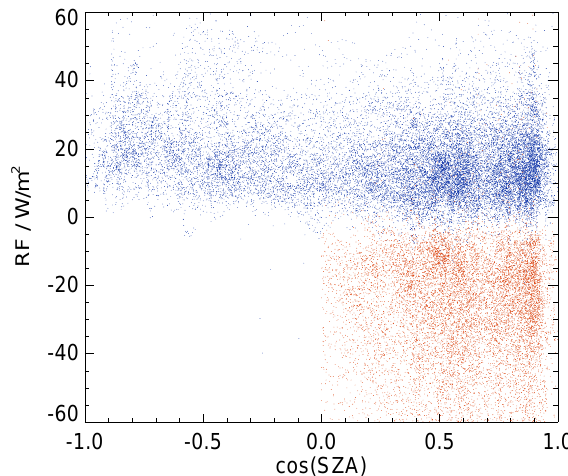
Figure 11. Probability density function of the cosine of solar zenith angle corresponding to the contrails in the data set.